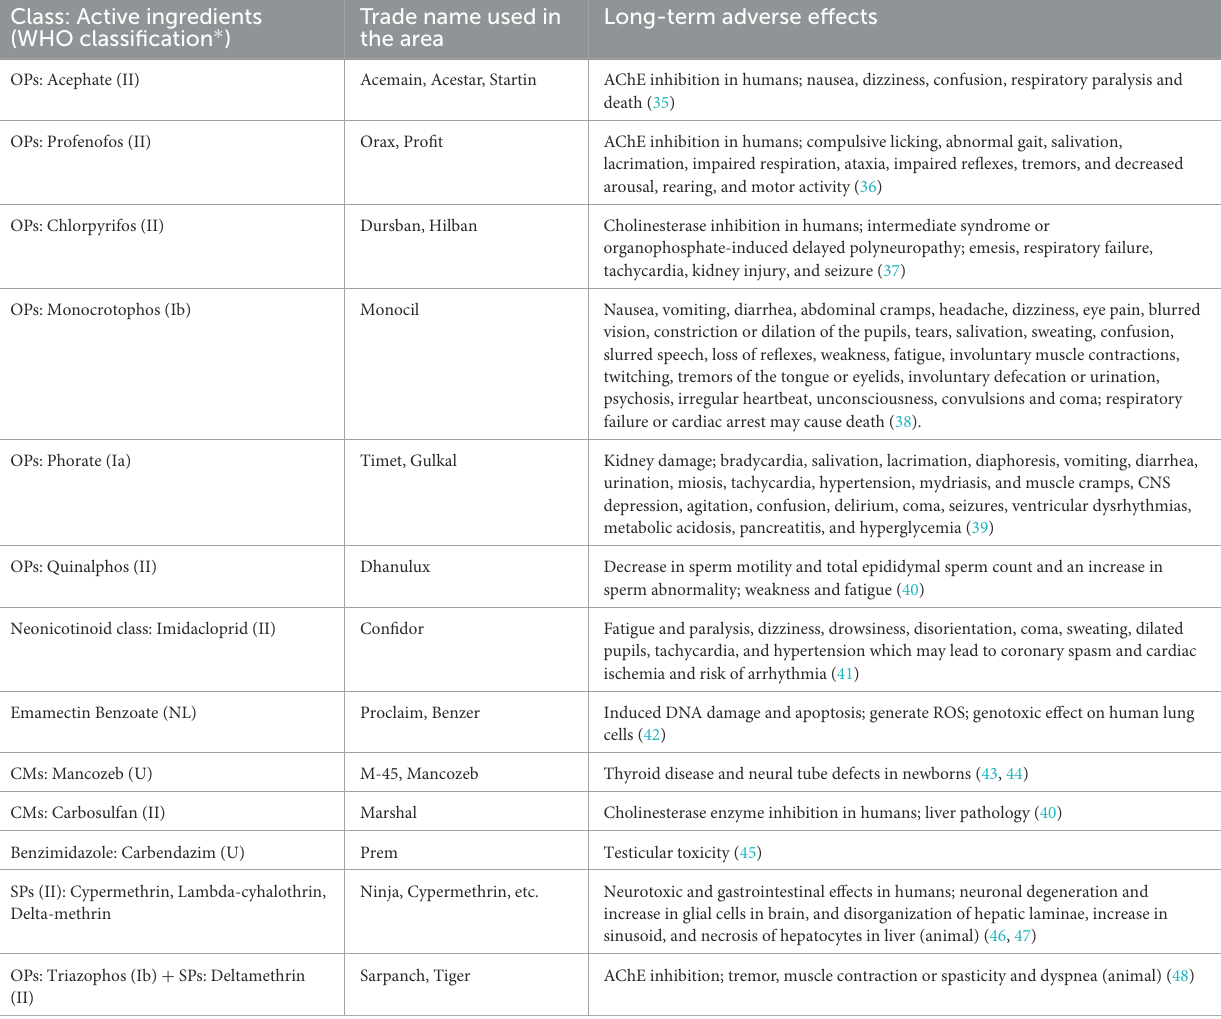
TABLE 3 Commonly used pesticides in the studied area and the long-term adverse effects.